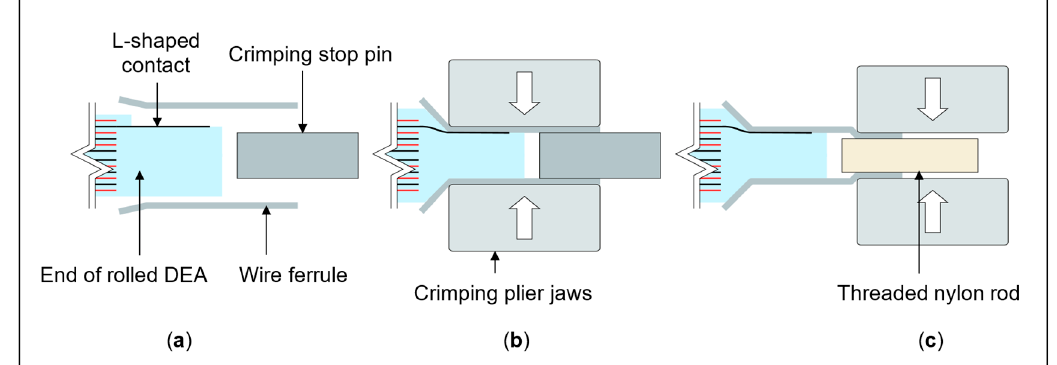
Figure 7. Schematic depiction of the crimping process. One end of the rolled DEA with the exposed L ‐ shaped contacts and a crimping stop pin with a defined diameter is inserted into the ferrule ( a ). Radial crimping pliers are used to crimp the ferrule ( b ). Finally, the crimping stop pin is removed, and the threaded nylon rod is crimped ( c ).